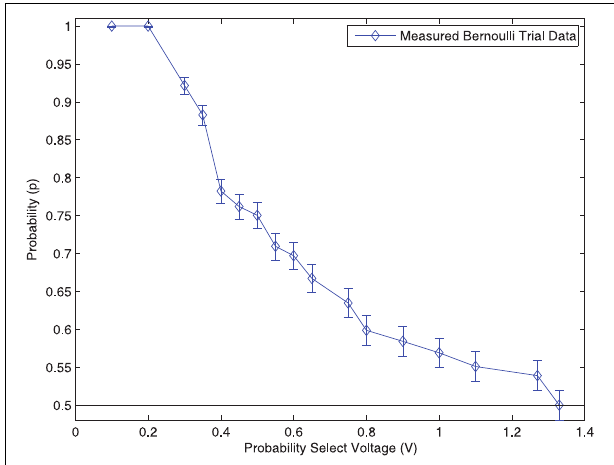
FIGURE 10 | Measurements from the output of the Dynamic Bernoulli Probability Circuit shown in Figure 3 were taken. The “Probability Select” voltage was adjusted from 0.1 volts up to 1.4 volts and the resulting probability of a digital “1” being produced was recorded with a 95% confidence interval. Measurements were only taken down to p = 0 . 5 since a Bernoulli trial is symmetric about this value.